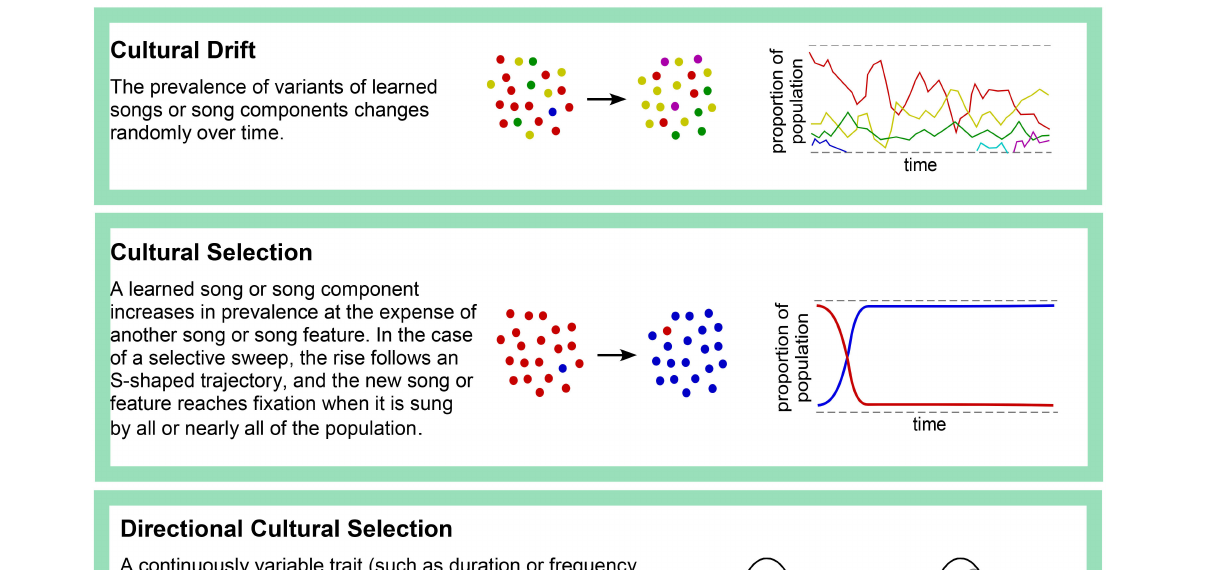
TABLE 1 | Some mechanisms for the cultural evolution of